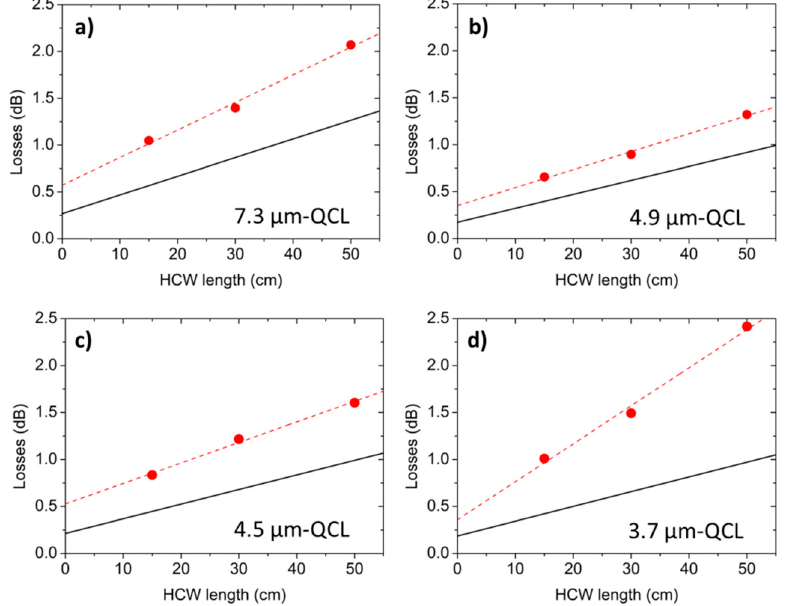
Figure 4. ( a – d ) Total losses ( ● ) measured when coupling the 7.3- μ m- ( a ), 4.9- μ m- ( b ), 4.5- μ m- ( c ) and 3.7- μ m-QCL ( d ) beams into the HCWs having lengths of 15, 30, and 50 cm, plotted as a function of the HCW length. Dashed lines are linear fits to the data. Solid lines are the theoretical losses calculated by using Equations (6) and (7).